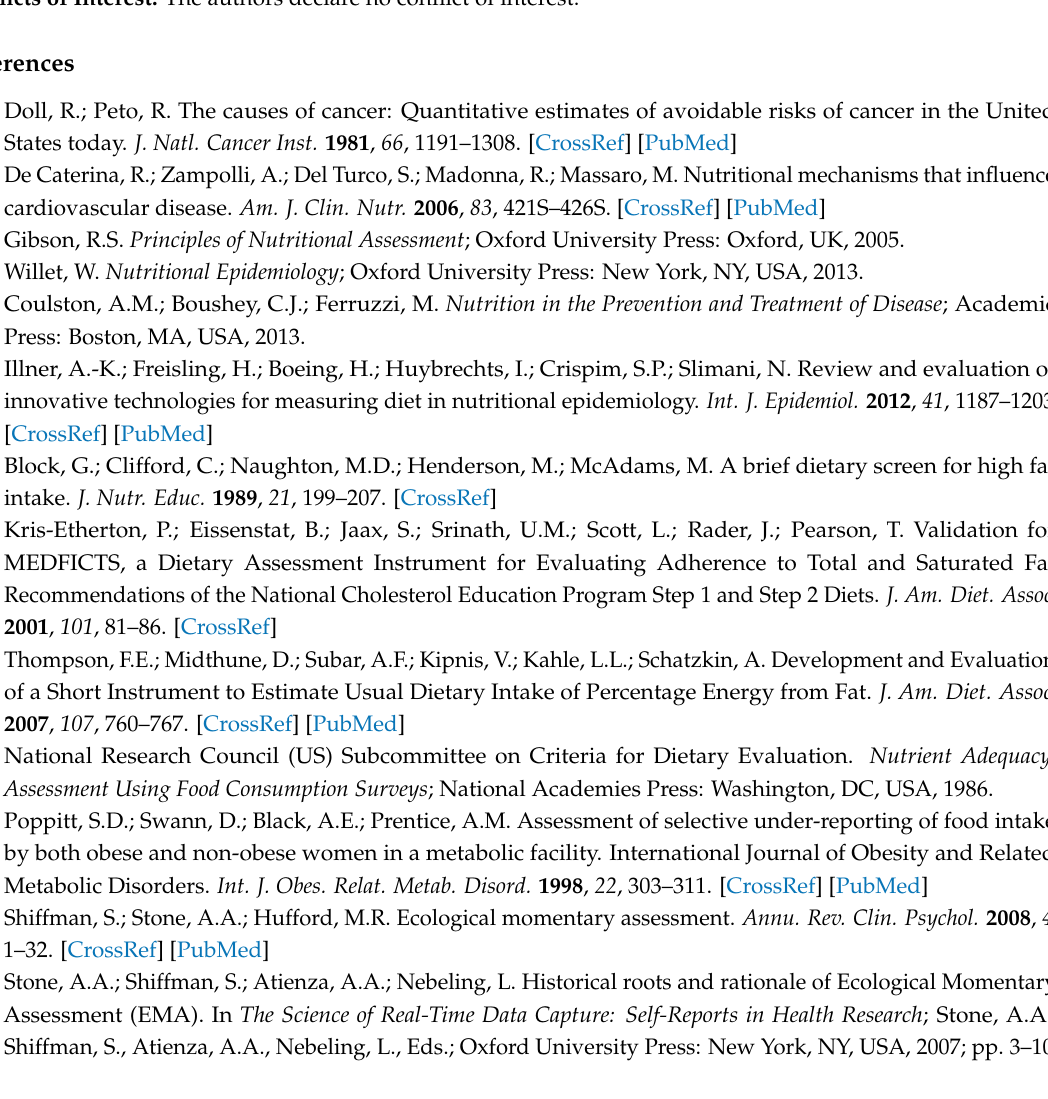
s1. Figure S1 Bland–Altman plot of individual differences between the app and the corrected app data. In the corrected app data, only valid days were considered. Valid responses were those in which respondents gave replies to at least three prompts on at least five